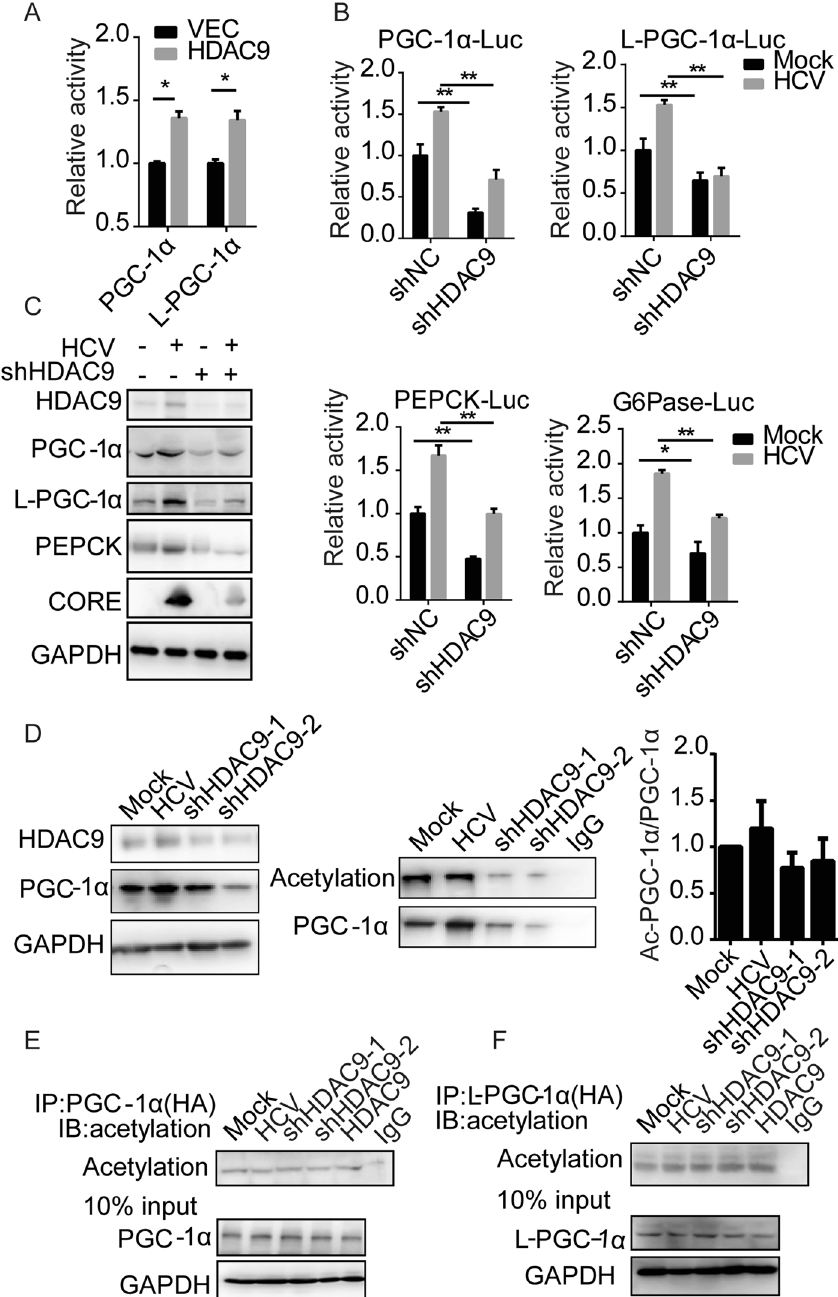
Figure 3. HDAC9 strongly activates PGC-1 α gene transcription. ( A ) The promoter activity of PGC-1 α and L-PGC-1 α in HDAC9-overexpressing cells. ( B ) The promoter activity of PGC-1 α , L-PGC-1 α (upper panel), PEPCK or G6Pase (lower panel) in HuH7-shHDAC9 cells. Data are represented as the mean ± SEM for triplicate experiments. ( C ) Related protein levels as indicated in ( B ). ( D ) Endogenous PGC-1 α (second panel) was immunoprecipitated from the indicated cell lysates and immunoblotted with PGC-1 α and acetylated lysine antibodies. The histogram (third panel) represents a densitometric analysis performed to quantify the relative intensity of Ac-PGC-1 α /PGC-1 α -immunoreactive bands detected by Western blotting. Exogenous PGC-1 α ( E ) and L-PGC1 α ( F ) were immunoprecipitated by HA antibody from the indicated cell lysates and immunoblotted with acetylated lysine antibodies. The whole cell lysate for immunoprecipitation was immunoblotted with the antibodies indicated in ( D - F ). Goat-anti-rabbit-IgG or Rabbit-anti-mouse was used as the negative control in ( D – F